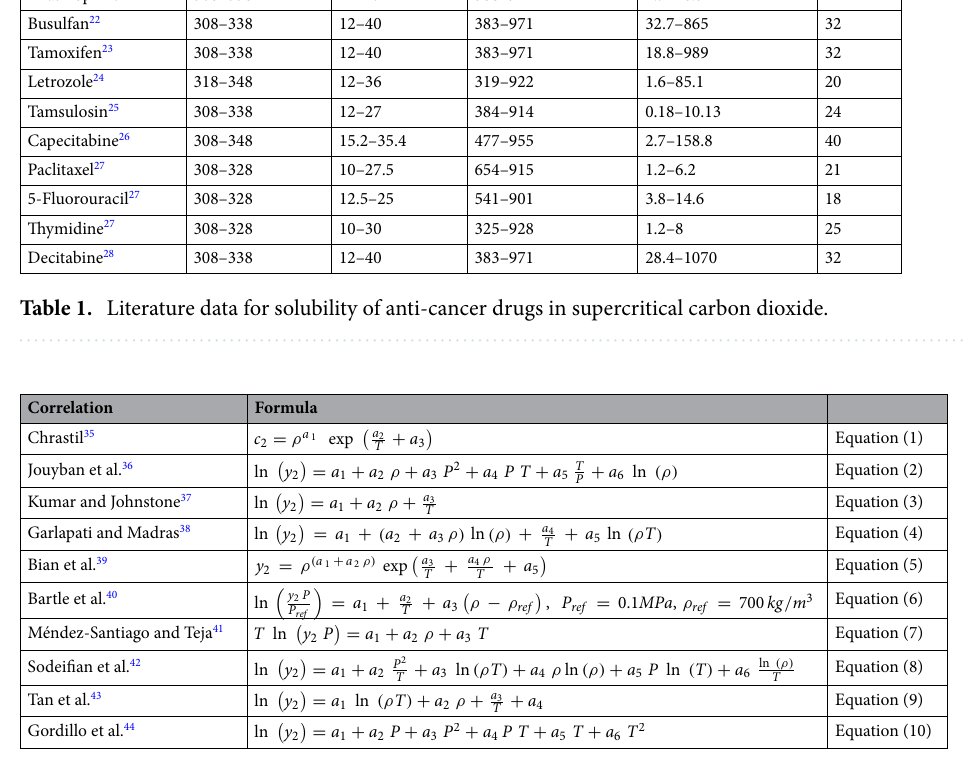
Table 2. Available empirical correlations for solute/drug solubility in supercritical carbon dioxide.